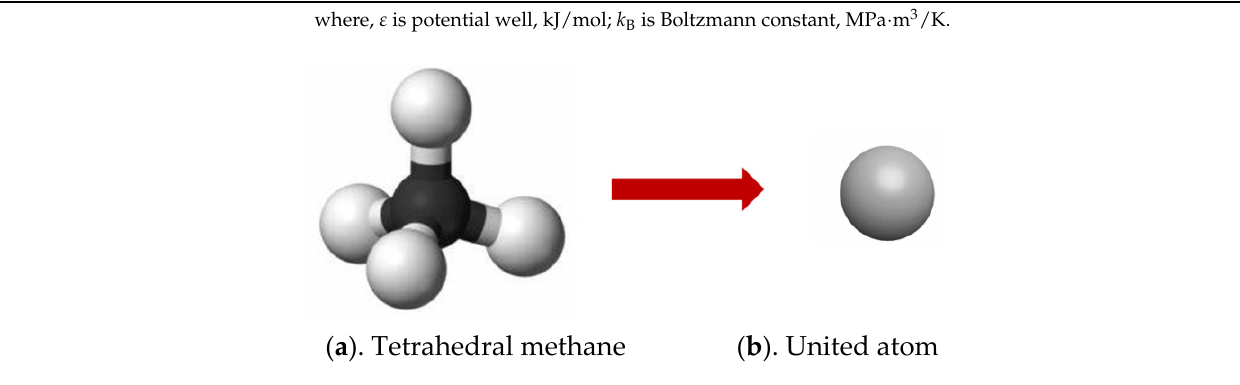
Figure 1. Different expressions of methane.